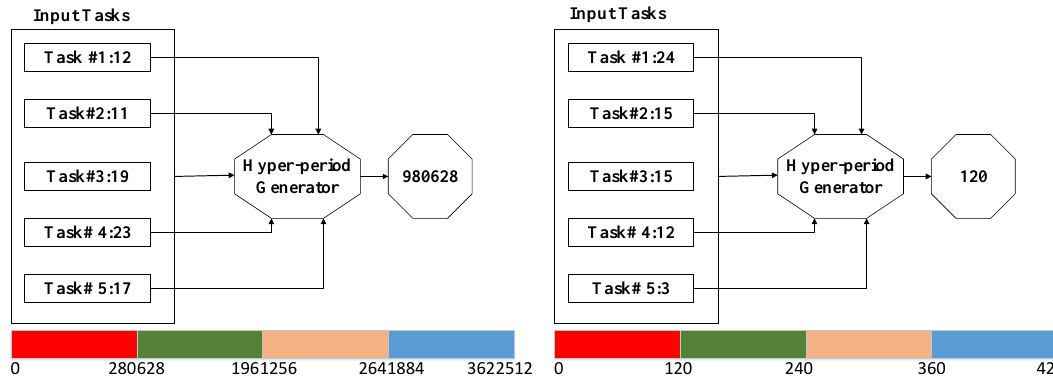
Figure 2. Hyper-period comparison of different task sets and its effect on CPU clock